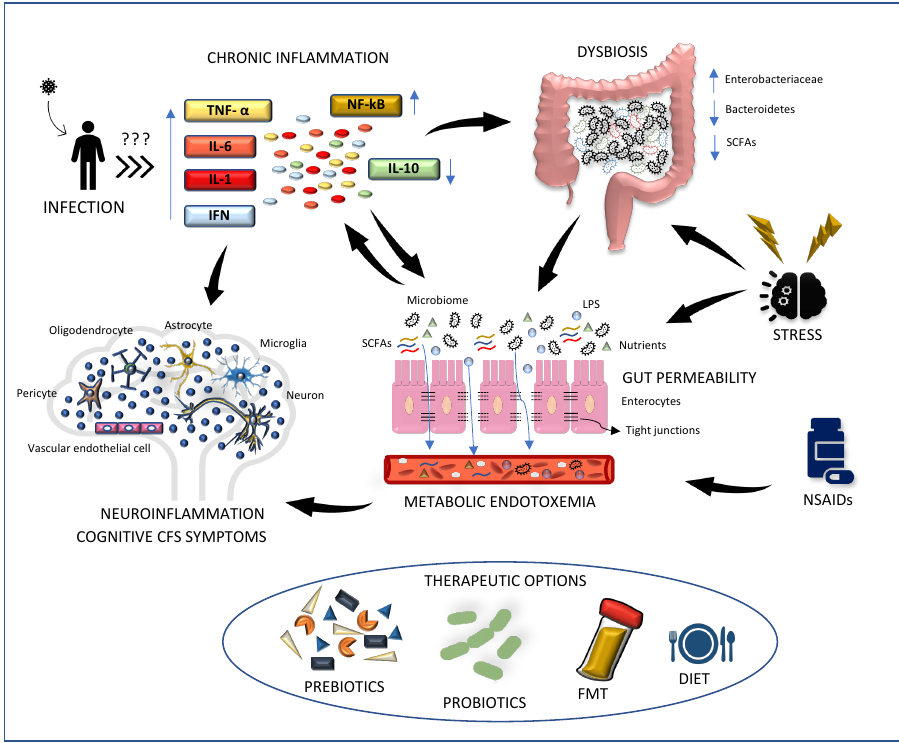
Figure 1. Role of dysbiosis and gut permeability in ME/CFS